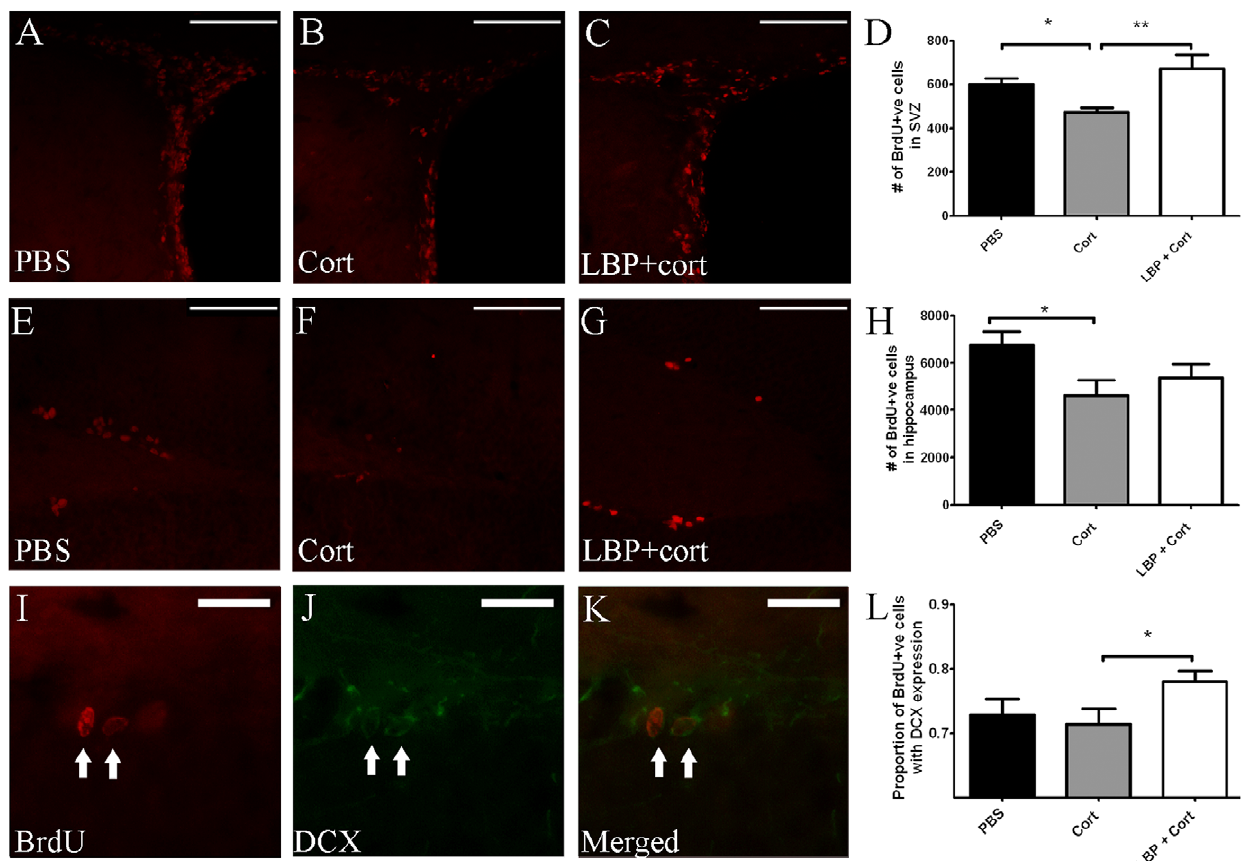
Figure 4. Effect of corticosterone and/or LBP treatment on SVZ and hippocampal neurogenesis. Representative microphotograph of BrdU-positive cells in SVZ of (A) vehicle (B) corticosterone and (C) co-treatment with corticosterone and LBP groups are shown. Corticosterone treatment significantly decreased cell proliferation when compared to vehicle (p , 0.05) and co-treatment (p , 0.01) groups (D). Representative BrdU- staining of hippocampus are shown in (E [vehicle]), (F [corticosterone]) and (G [co-treatment]). Corticosterone group showed a lower number of BrdU- positive cells than the vehicle group (H, p , 0.05). Co-immunostaining of BrdU and DCX experiment (I-K) showed that co-treatment group showed a significantly higher proportion of DCX/BrdU ratio than the corticosterone group (L) Arrows indicates co-labeled cells. Analyzed by ANOVA with LSD post-hoc test. Data are expressed as mean 6 SEM. Scale bars: A-C & E-G: 50 m m; I-K: 25 m m.